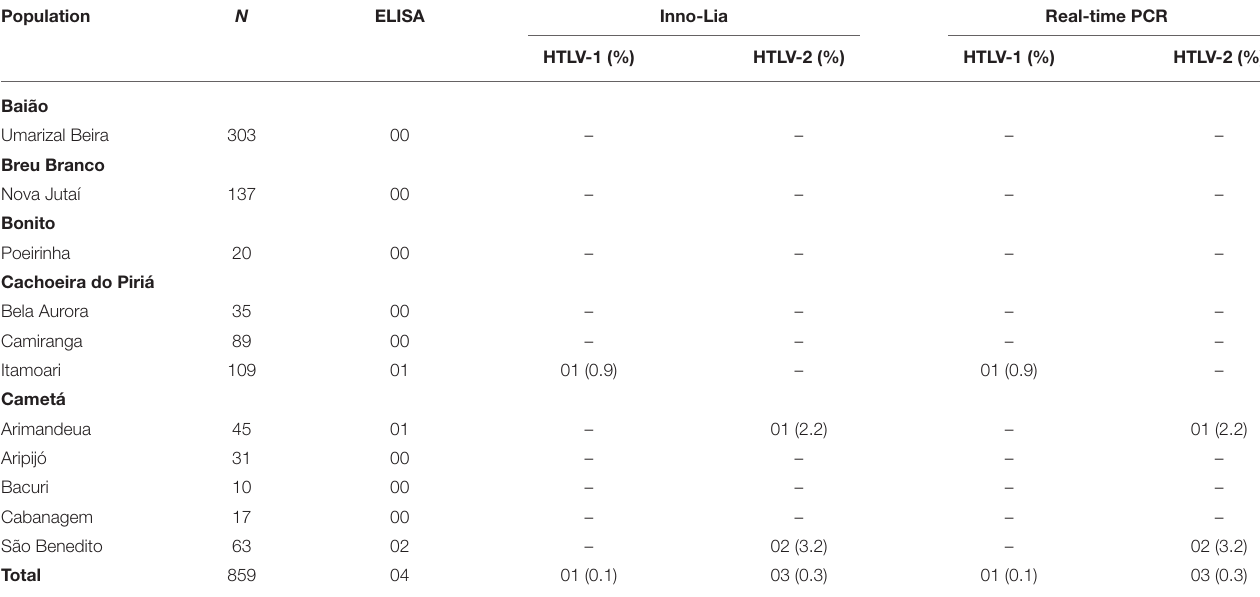
TABLE 2 | Prevalence of HTLV-1 and HTLV-2 in the communities based on the tests used. Population